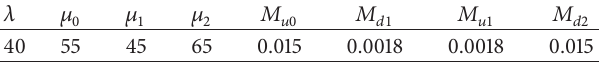
Table 2: Fixed-path mobility with nonoverlapping networks.